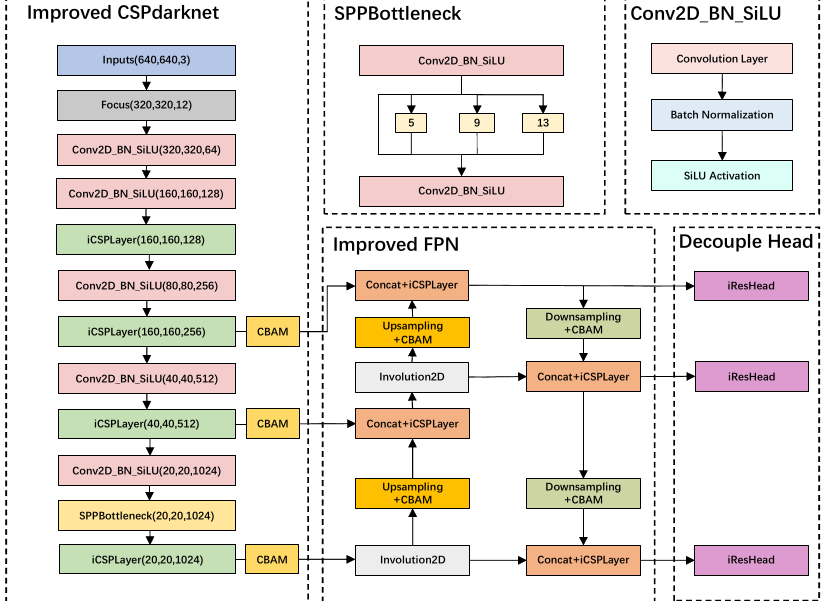
Figure 3. i-YOLOX network architecture diagram. Improved CSPdarknet is the backbone of i-YOLOX. FPN is feature pyramid network. Decoupled head is the detection of i-YOLOX. SPP is spatial pyramid pooling. Conv2D_BN_SiLU is a stacked structure containing a two-dimensional convolutional layer, a batch normalization layer, and a sigmoid-weighted liner unit layer.